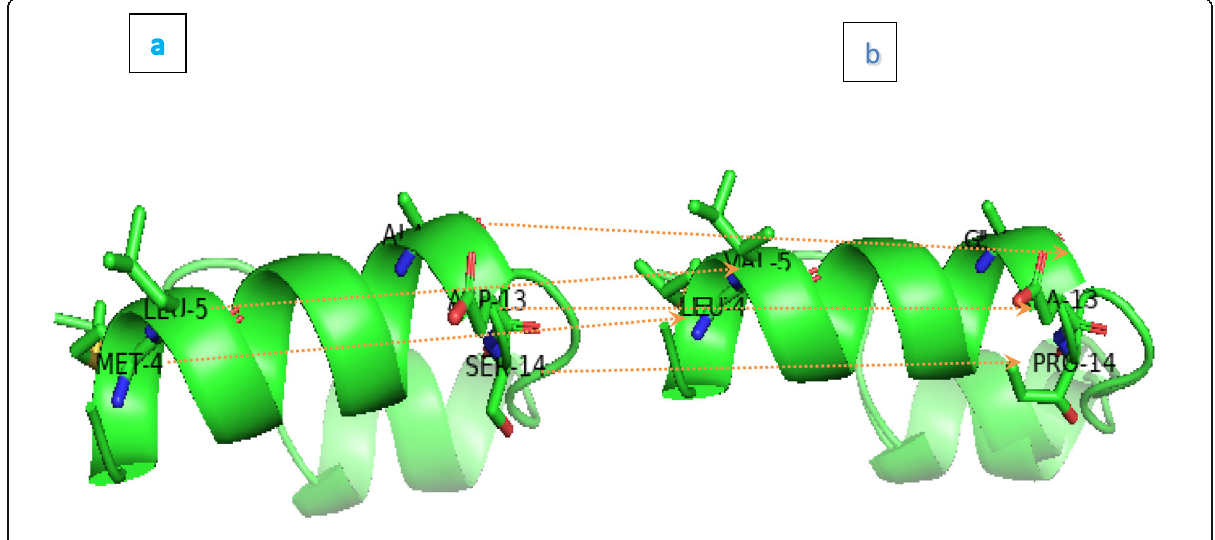
Fig. 3 Three-dimensional profile of BMP15 which exhibited the in silico prediction of BMP15 SNPs. a reference type and (b) mutant type